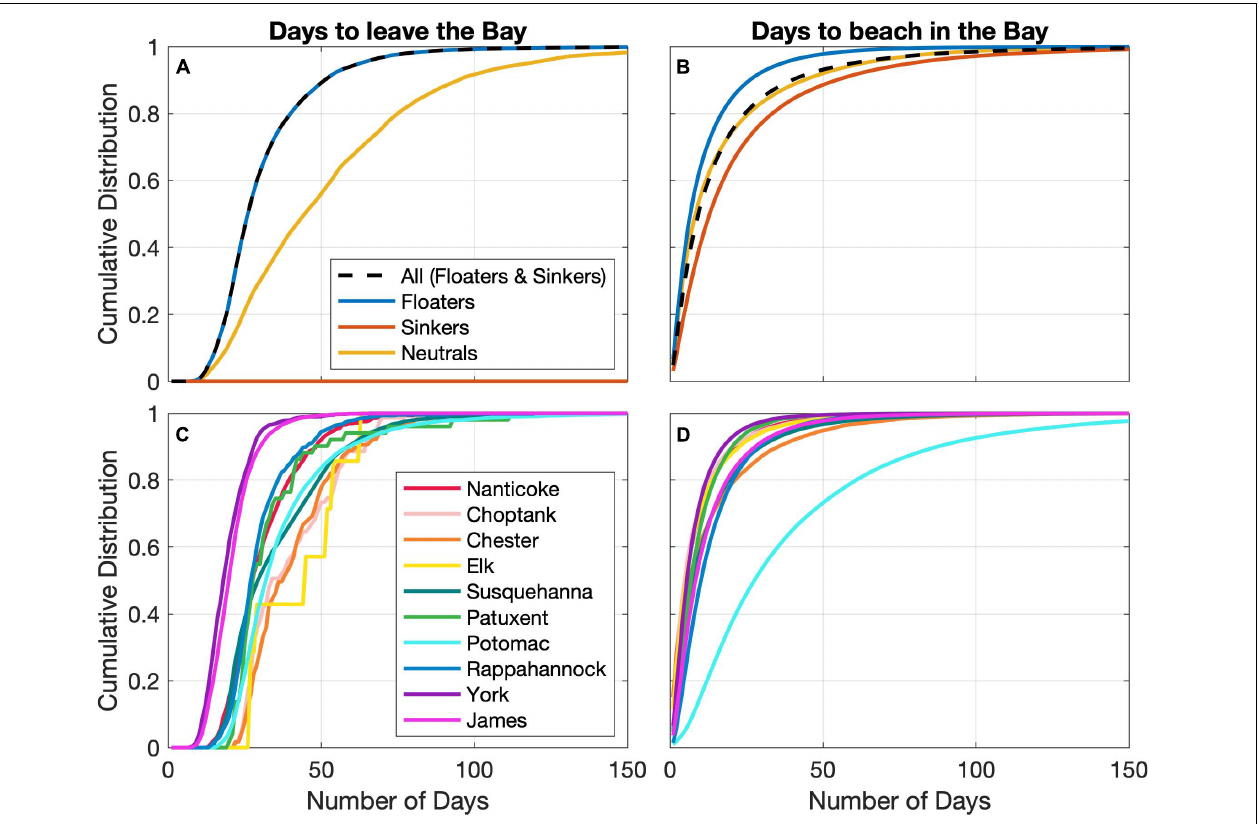
FIGURE 6 | Cumulative distribution plots for the timings of particles to either (A,C) leave the Bay or (B,D) beach inside the Bay. (A,B) Are for all positively, negatively, and neutrally buoyant particles, as well as the mean of all floaters and sinkers. (C,D) Are the composite case mean (floaters and sinkers) for the individual source